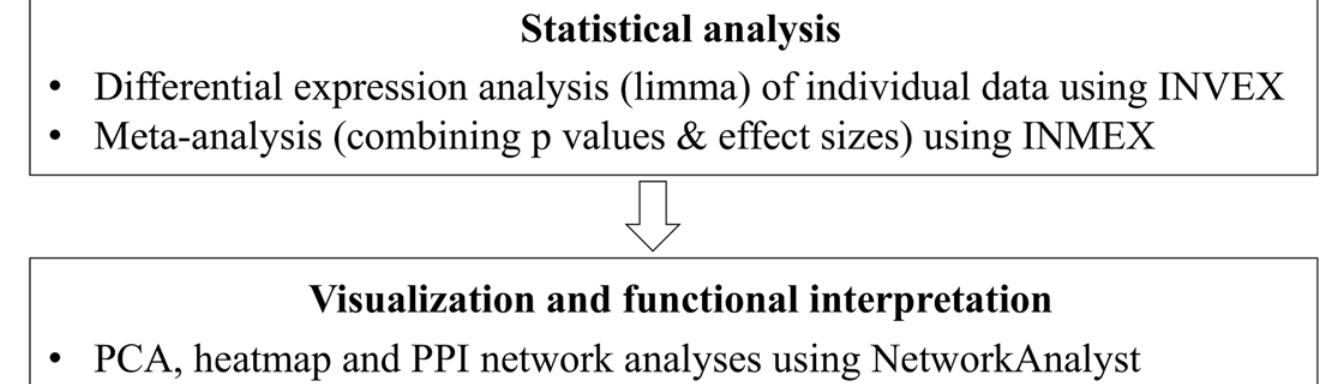
PLOS Neglected Tropical Diseases | DOI:10.1371/journal.pntd.0004624 April 8,